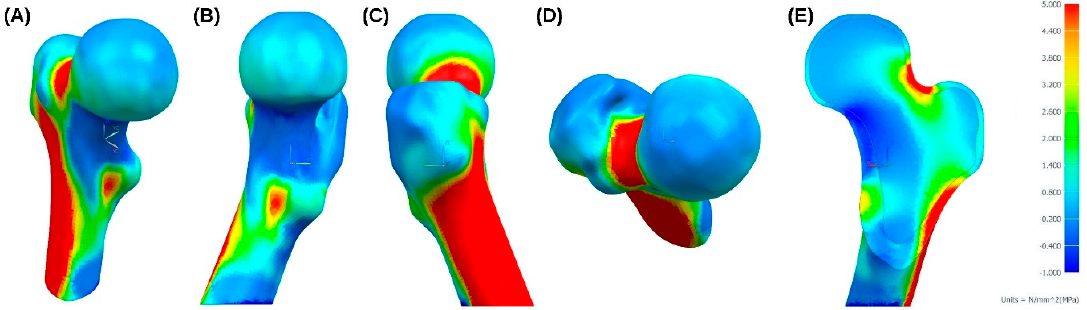
Figure 13. ( A ) Isometric, ( B ) right, ( C ) left, ( D ) top and ( E ) back view of maximum principal stress in proximal femur when applying the ISO force.